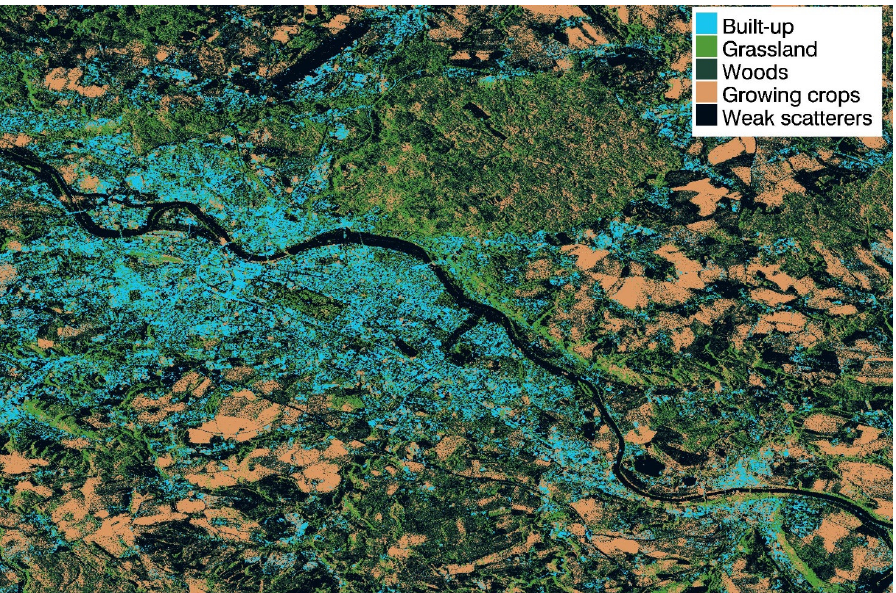
Figure 5. Dresden (Germany), 5-class land cover map with a 15 m spatial resolution obtained through